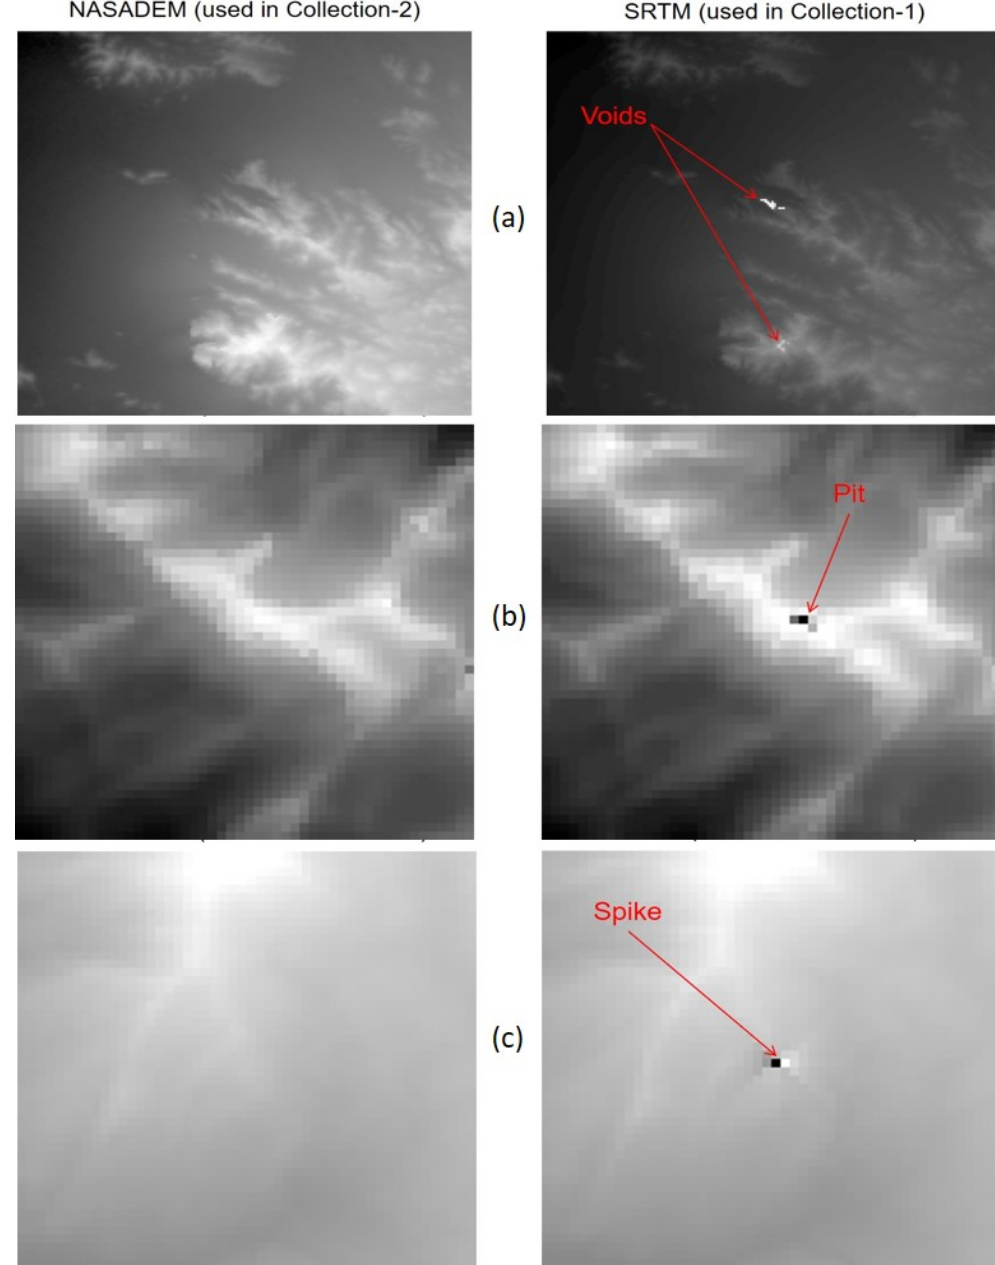
Figure 12. Artifacts found in SRTM data using artifact detection algorithm. ( a ) Voids, ( b ) pits and ( c ) spikes.